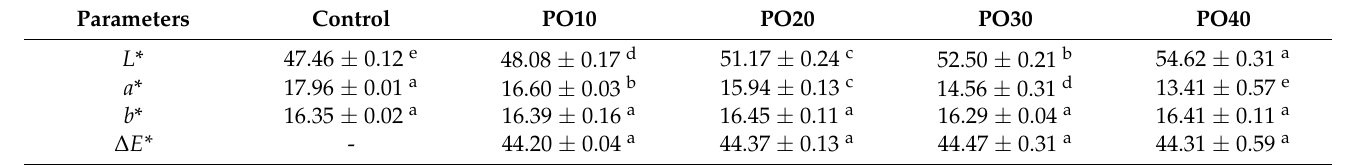
Table 3. Color comparison of Pleurotus ostreatus (PO) pork sausages.